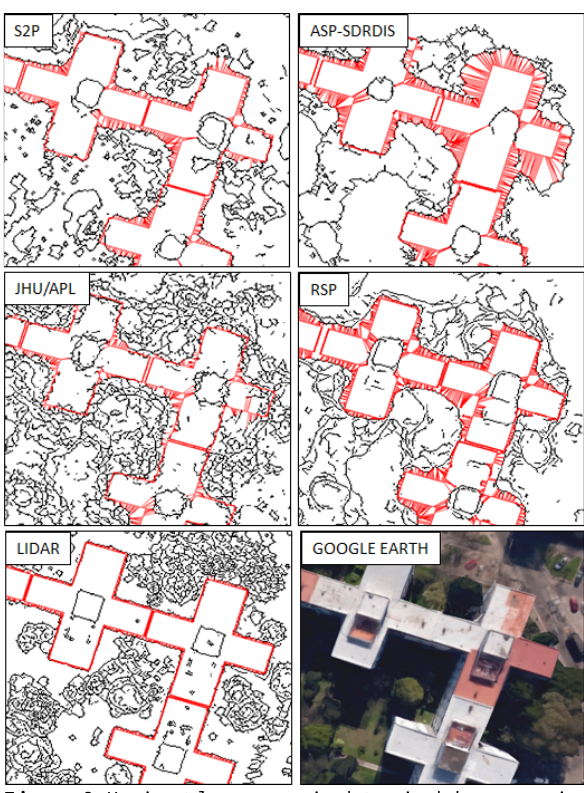
Figure 6 Horizontal accuracy is determined by measuring distances between sampled points on building polygons and nearest edge points.